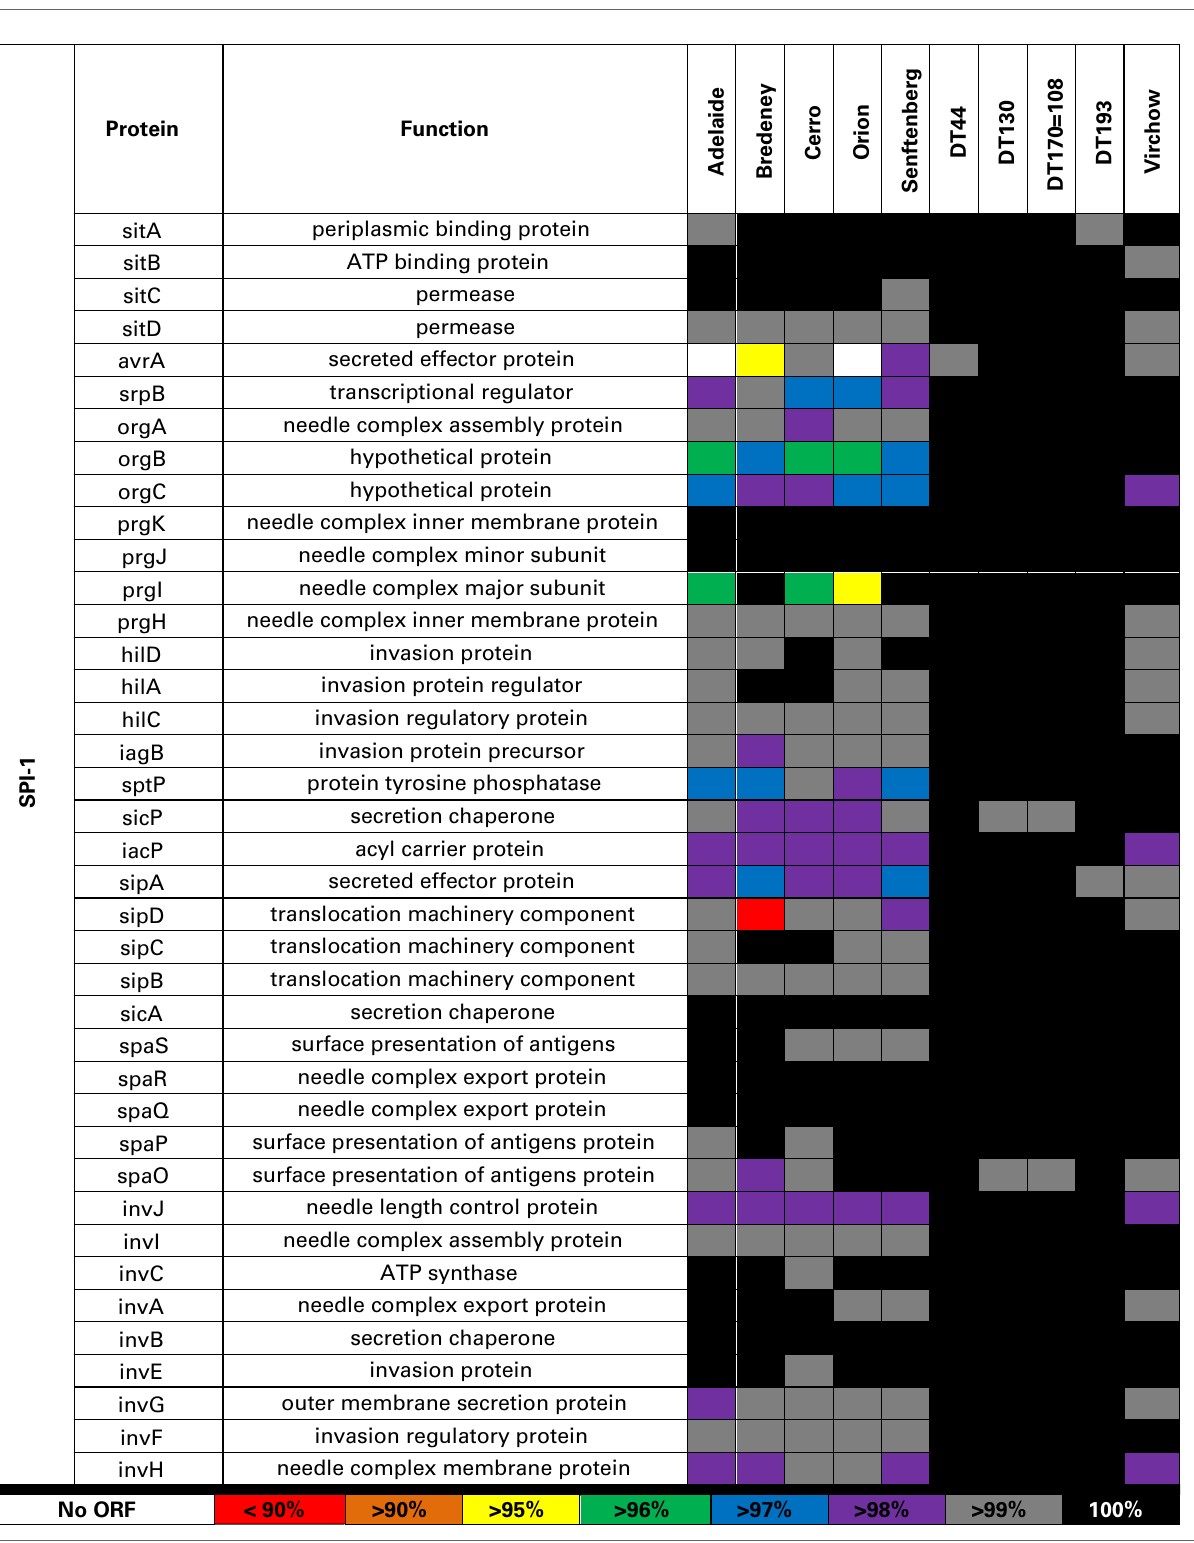
Table 4 | Comparative analysis of SPI-1 sequences from 10 NTS